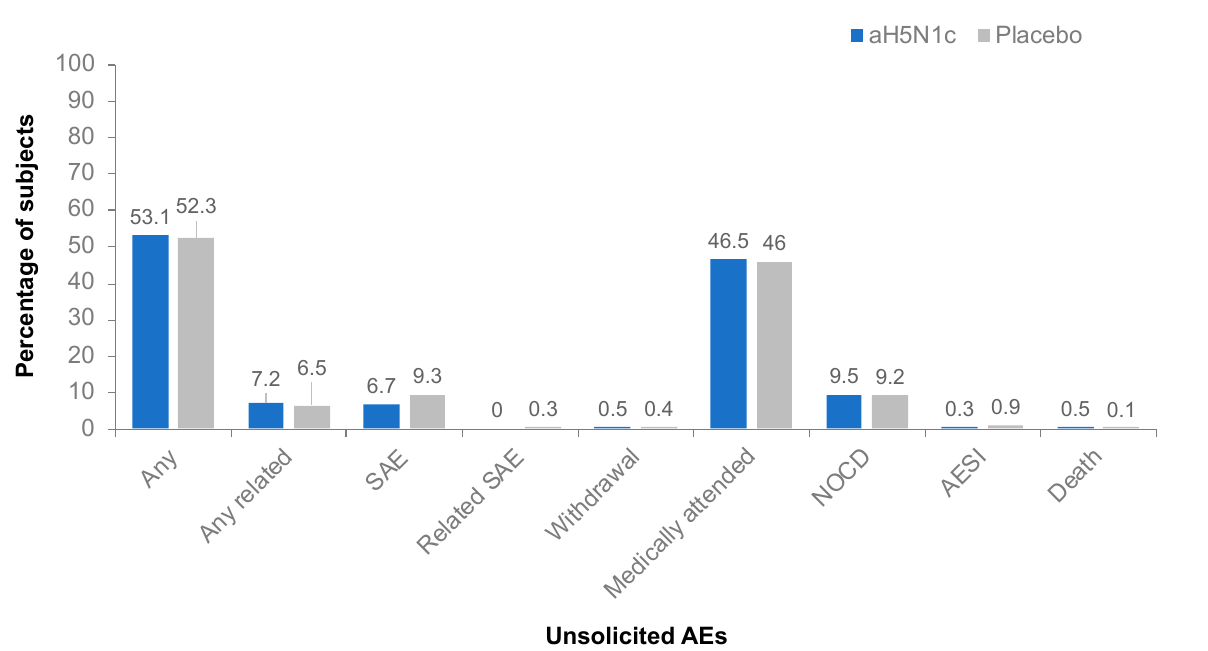
Figure 4. Percentages of subjects with unsolicited adverse events (AE), serious adverse events (SAE), AE leading to study withdrawal, medically attended AEs, new onset chronic disease (NOCD), AE of special interest (AESI), or death from Day 1 through study termination.